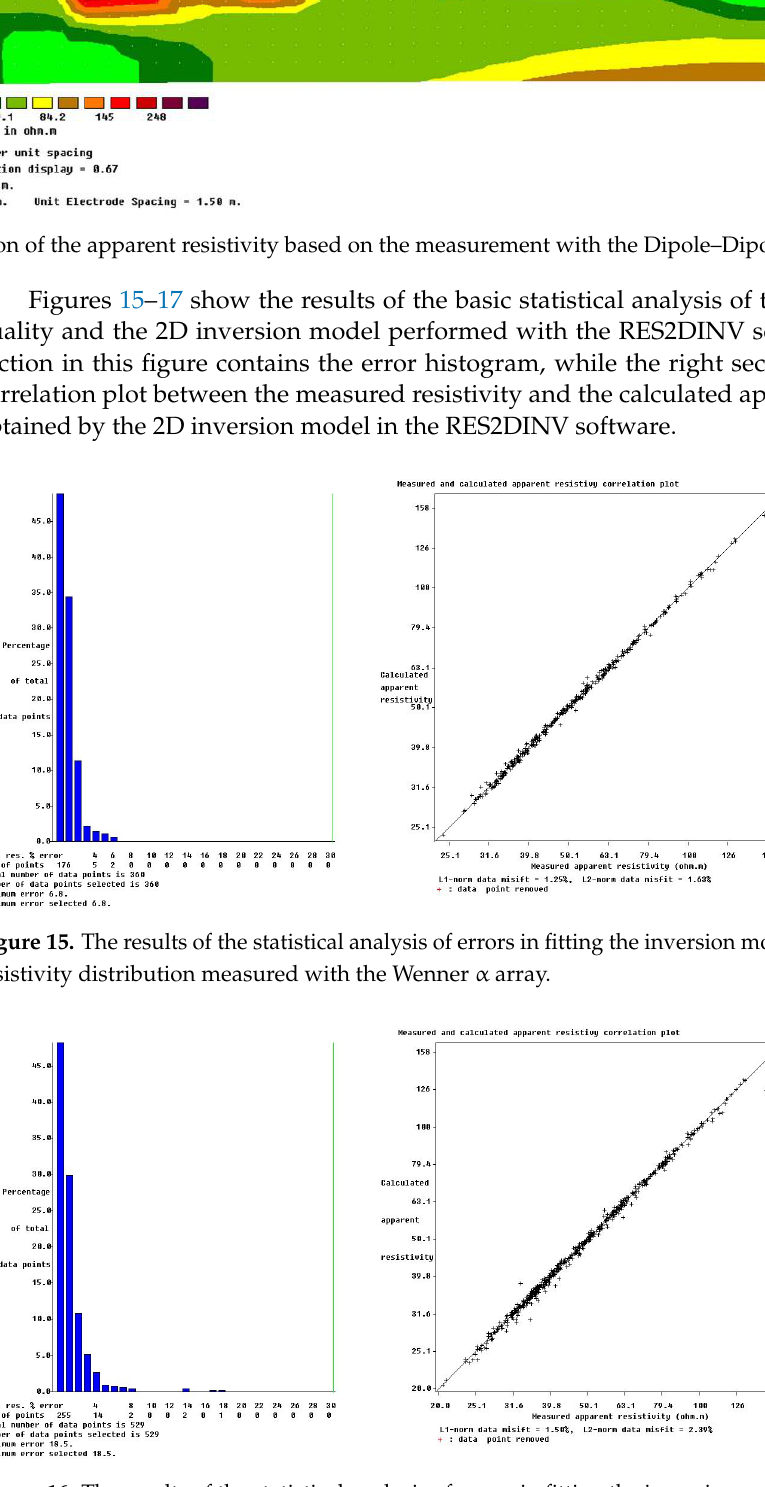
Figure 16. The results of the statistical analysis of errors in fitting the inversion model to the apparent resistivity distribution measured with the Wenner–Schlumberger array.